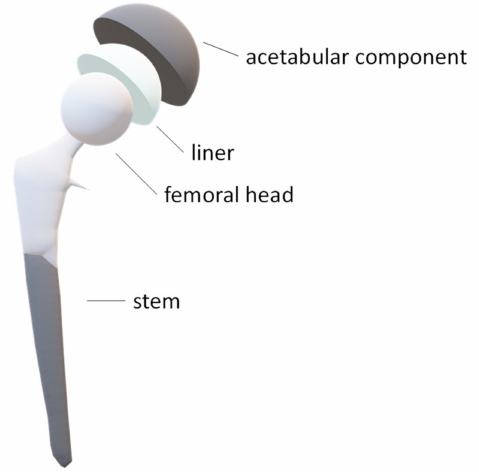
Figure 1. Sketch of the typical components of a total hip